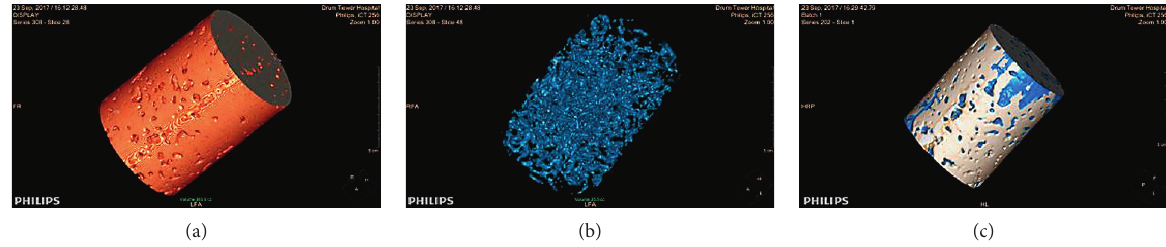
Figure 13: Holistic three-dimensional reconstruction imaging.